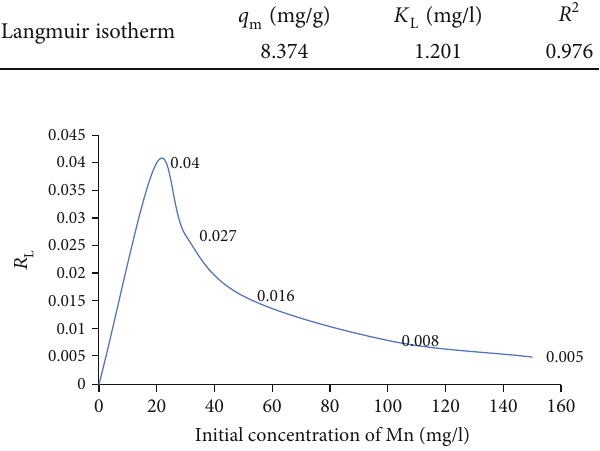
Table 2: Freundlich isotherm parameters. Freundlich isotherm